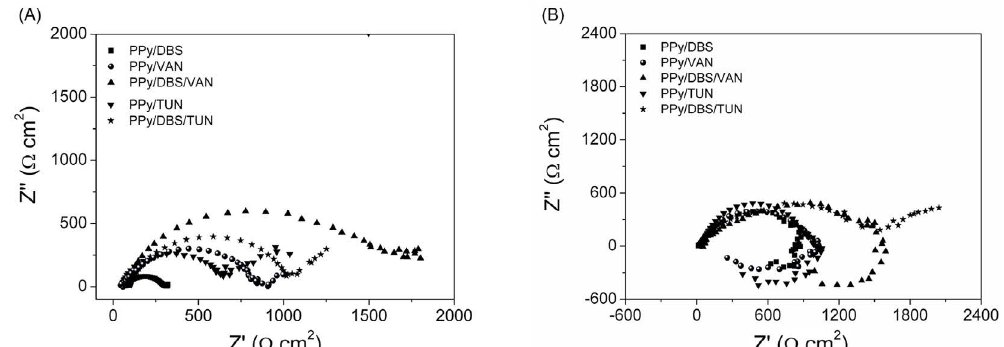
Figure 4. Nyquist plots of the AA 1100 electrode coated with PPy films, after 1 h of immersion in (A) 0.05 mol L -1 NaCl and (B) 0.05 mol L -1 HCl solutions.